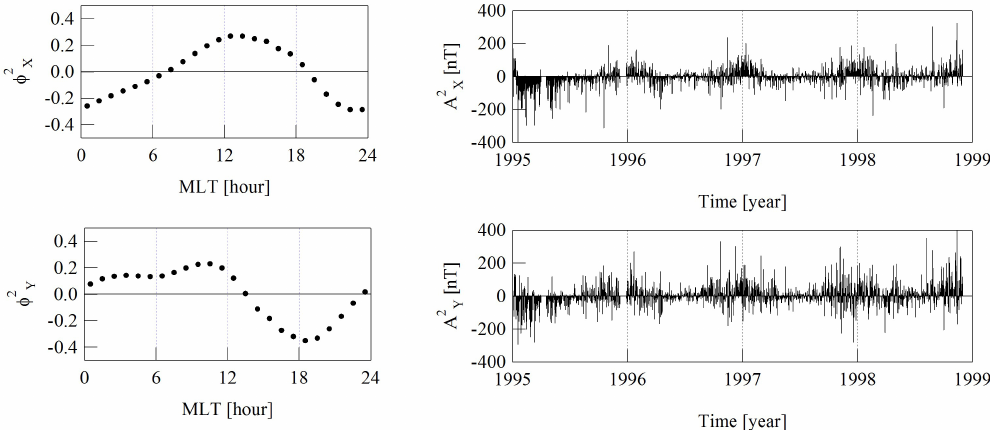
Fig. 3. On the left, the second EOF associated to the X (top) and Y (bottom) components, respectively. On the right, the PCs associated to each EOF.